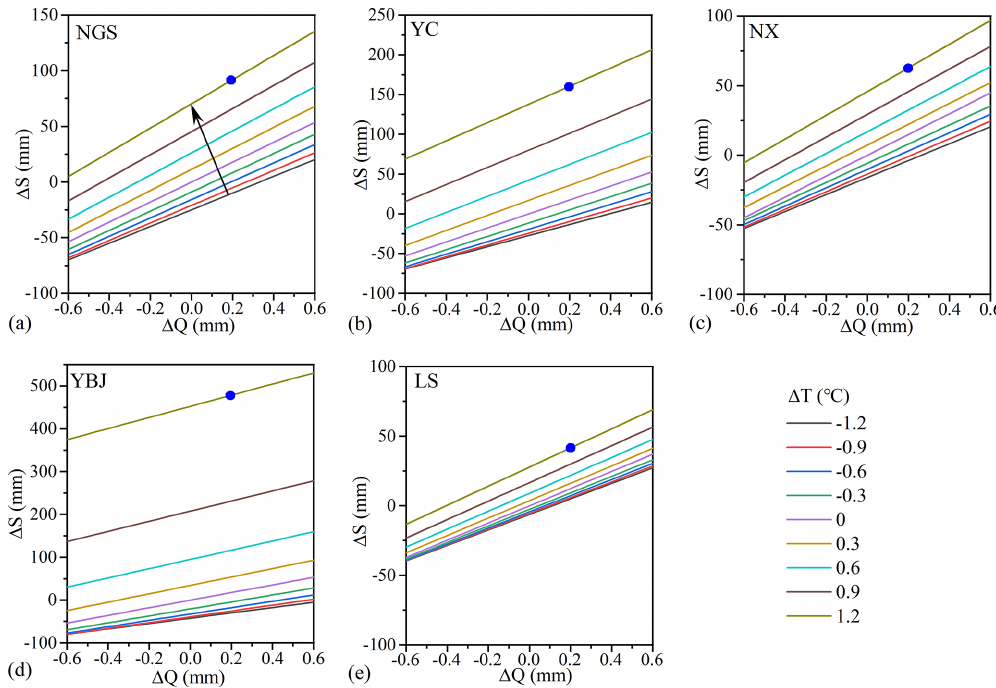
Figure 9. Changes in storage (cid:49)S in relation to changes in discharge (cid:49)Q under different changes in temperature (cid:49)T for each subbasin. The changes in temperature (cid:49)T refer to the annual values relative to mean annual temperature in the recession period during 1980–2015. The solid circle refers the point of (cid:49)S in response to 0.2mm of (cid:49)Q